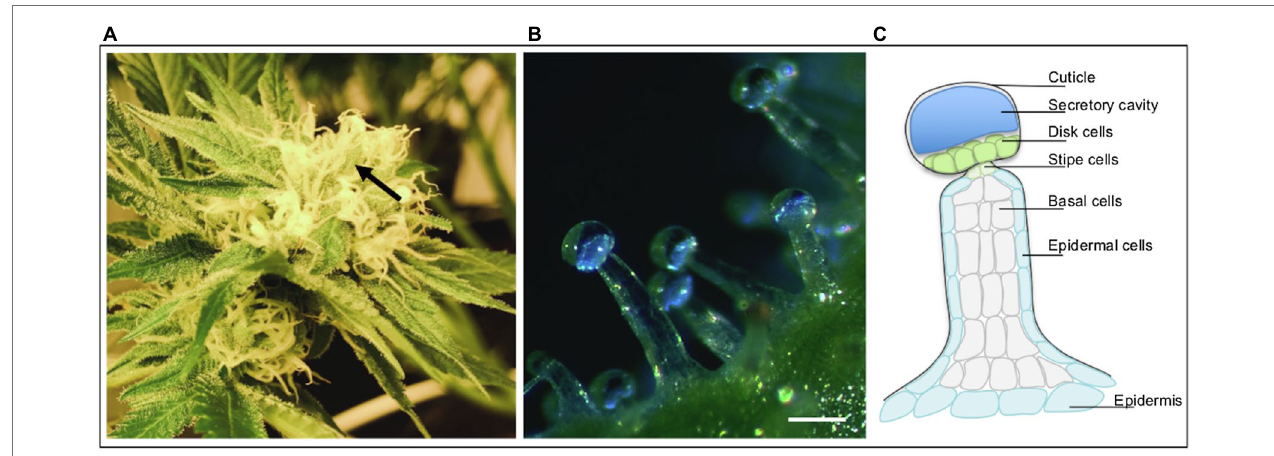
FIGURE 1 | Cannabis ( Cannabis sativa L.) inflorescence and trichomes. (A) An individual inflorescence, with majority of the organs covered in stalked glandular trichomes. Arrow indicates cluster of calyces and bracts covered with trichomes. (B) Dark field micrograph of stalked glandular trichomes protruding from calyx epidermis. Biosynthesis of secondary metabolites occurs in the secretory disk cells lining the base of the globular trichome head. The metabolites are stored in the clear subcuticular cavity above the secretory disk cells; this cavity will turn milky white to dark brown over the course of flower maturity. (C) Graphic illustration of stalked glandular trichome